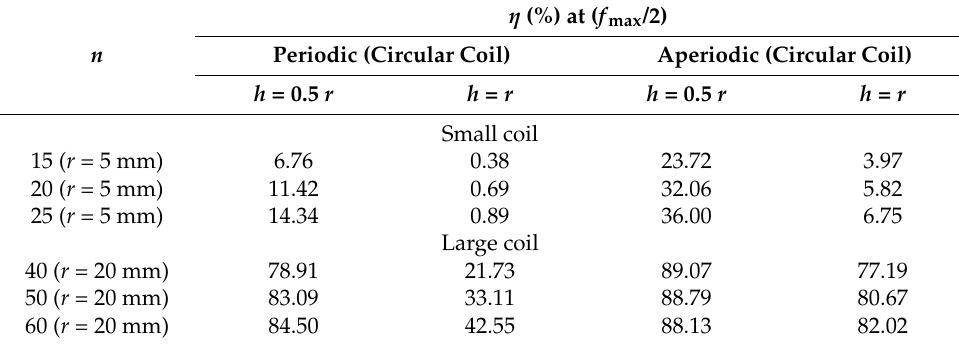
Table 7. The values of the power transfer efficiency at 500 kHz for a circular coil (periodic and